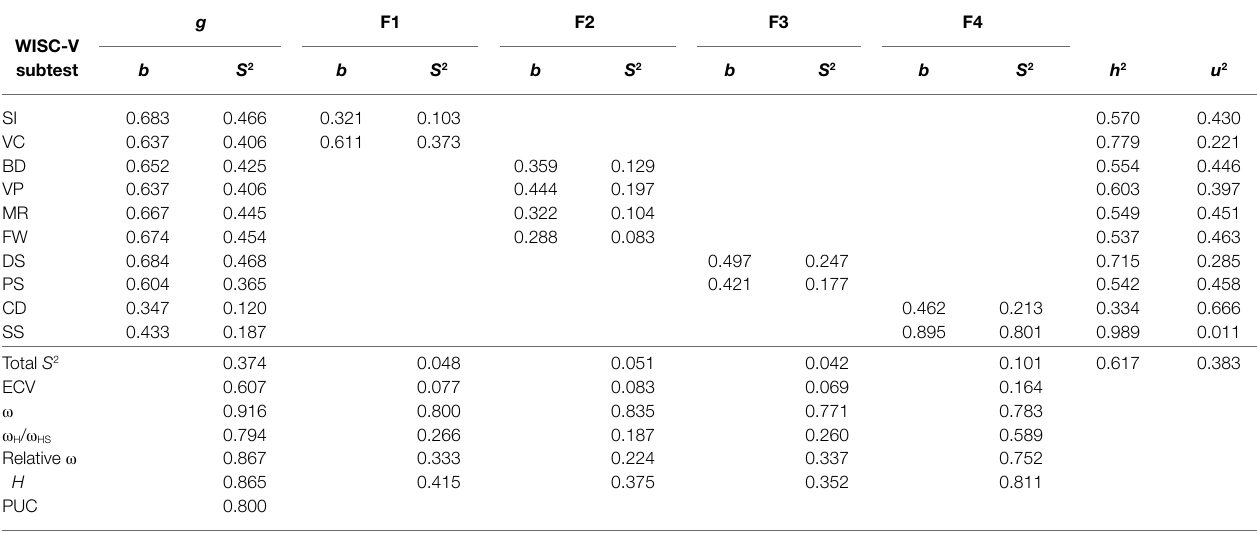
TABLE 7 | Sources of variance in the 10 WISC-V primary subtests for the CFA sample ( n = 823) according to a bifactor model with four group factors (M 6 ). g F1 F2 F3 F4 WISC-V subtest